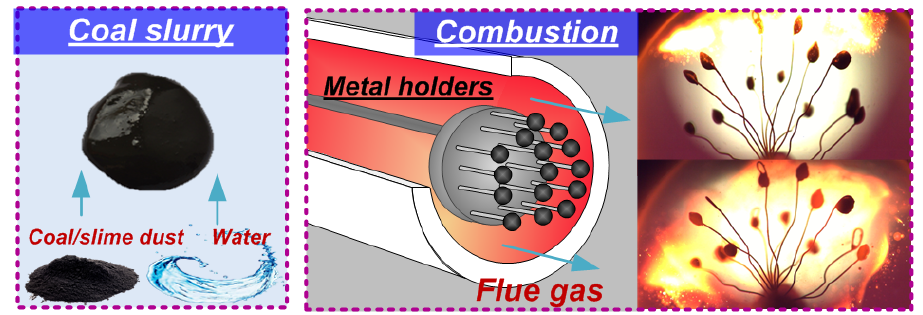
Figure 4. Combustion of coal–water slurry